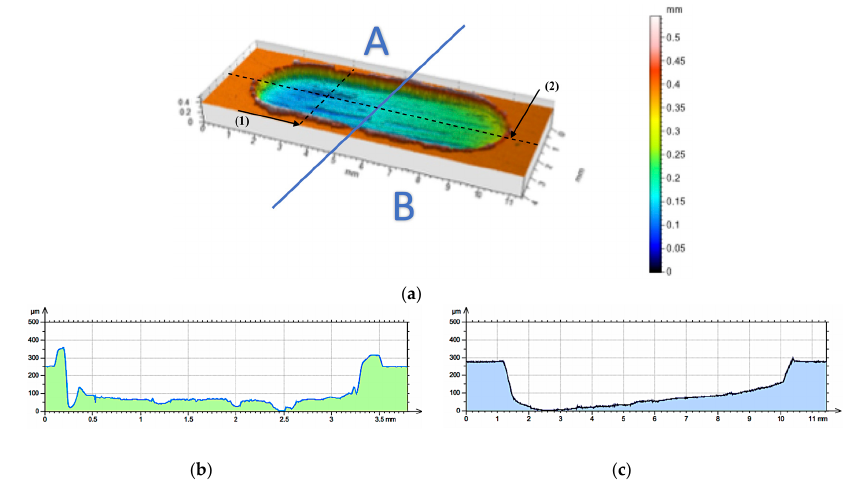
Figure 9. Initial state of surface geometry of the AlSi12/Al 2 O 3 _2 composite layer (P2): ( a ) 3D view; ( b ) height difference on line (1).